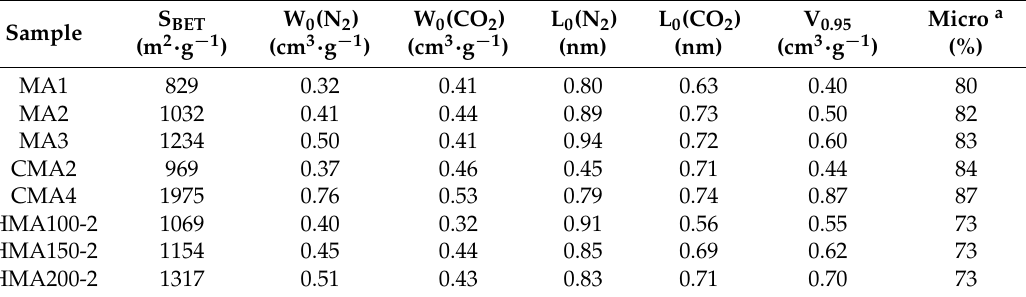
Table 3. Surface area and pore texture of the activated carbons.